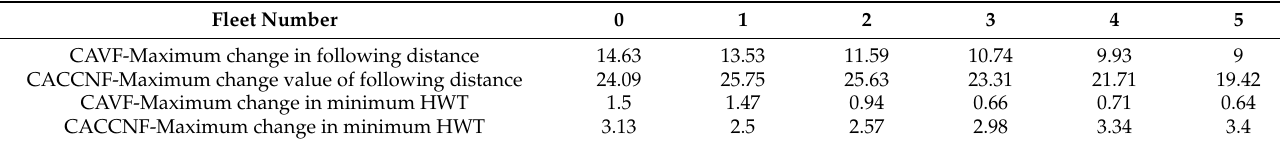
Table 1. Follow-up distance and HWT of CAVF and CACCNF teams.